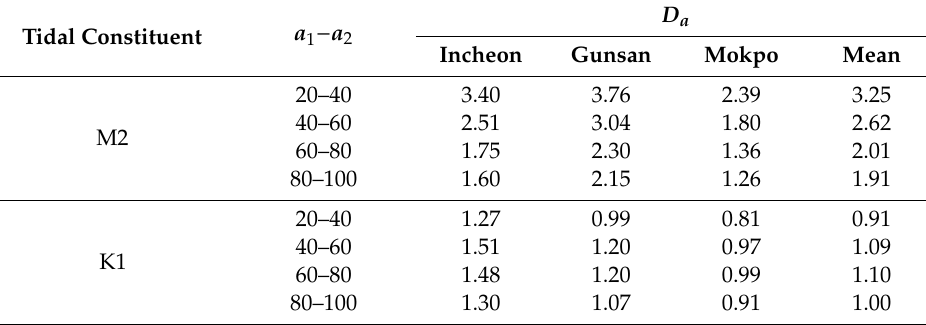
Table A13. D a per 1 cm increase of the tidal amplitude of K1 on the open boundary B. Tidal